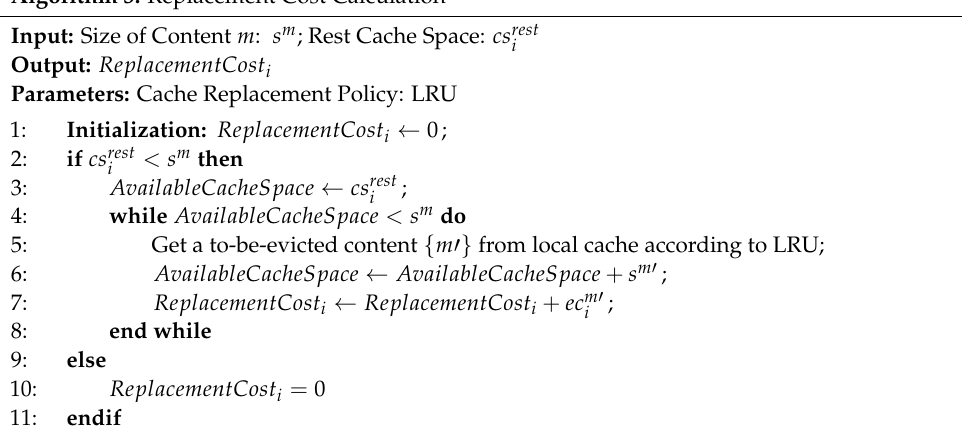
Algorithm 3: Replacement Cost